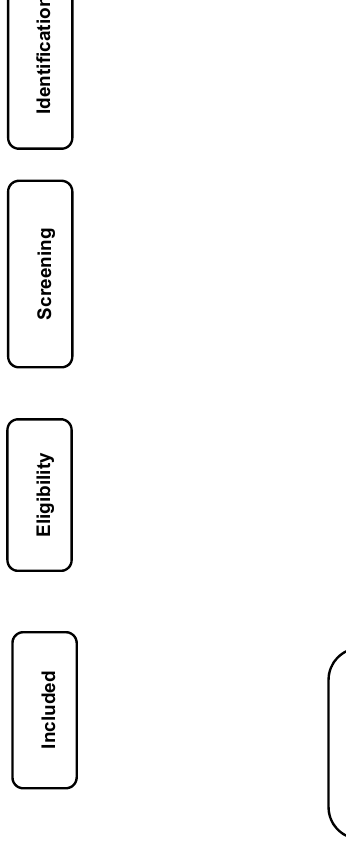
Figure 1. Flowchart of literature search.